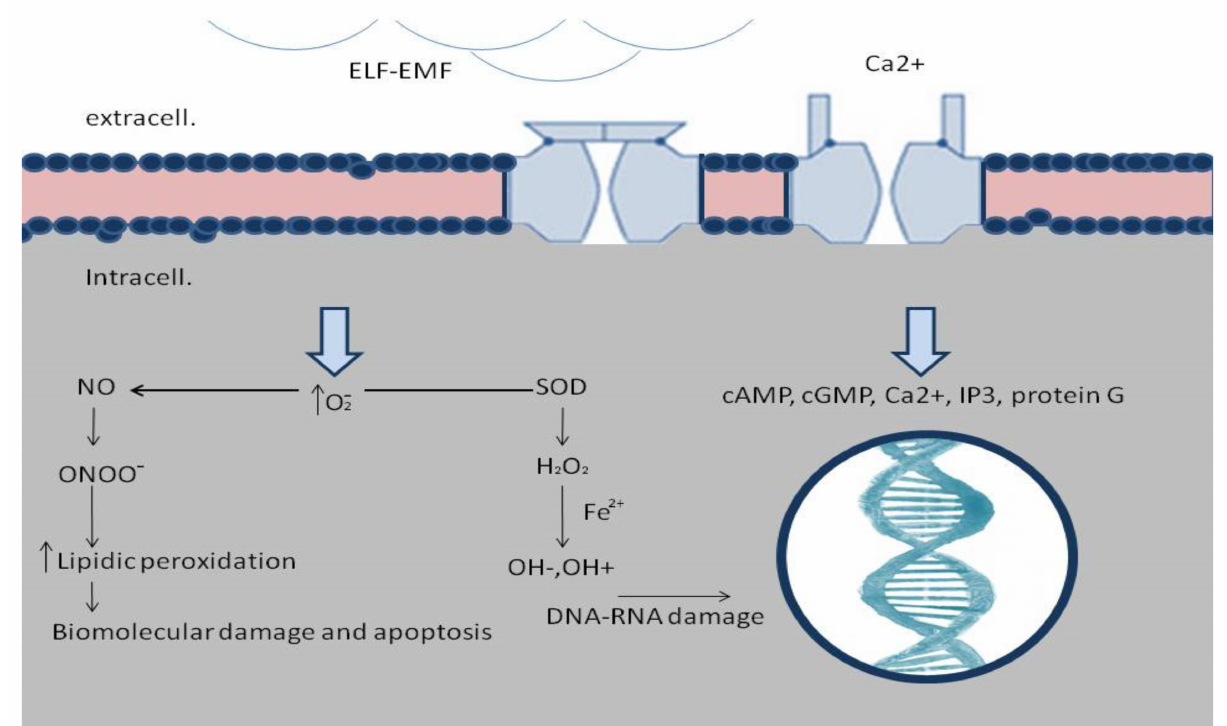
Figure 1. Molecular mechanisms of ELF-EMFs’ effects on cell function. ELF-EMFs open voltage-dependent calcium channels, causing interference in cell differentiation with Ca 2+ influx into cells. It is well documented that Ca 2+ ions affect activity-dependent gene expression, and this effect is mediated by signaling pathways activating Ca 2+ -responsive DNA regulatory elements. Decreasing antioxidants concentration has a defense mechanism against free radicals. The ELF-EMFs could also induce the production of oxygen (O 2 ) in the cellular environment, which plays a major role in oxidative damage that, subsequently, led to biomolecular damage, DNA double strand breaks, DNA/RNA damage, and cell